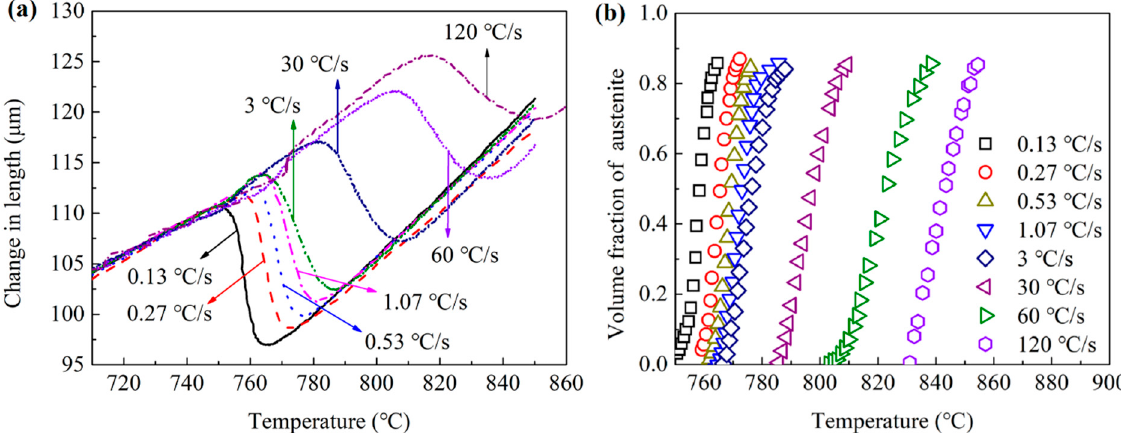
Figure 5. ( a ) The expansion curves for different heating rates; ( b ) the relationships between austenite volume fraction and temperature.